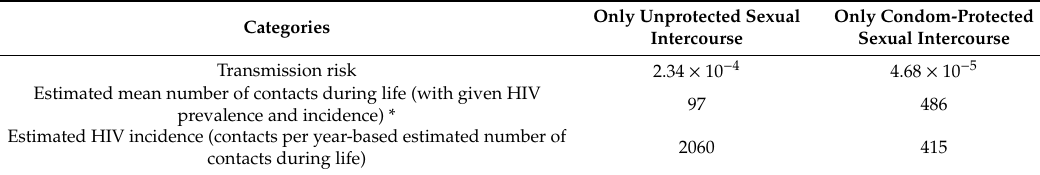
Table 2. Estimated mean numbers of sexual contacts and HIV incidence depending on use of condoms for prevention of transmission using Equations (4) and (6). Only individuals from the Haversath study [2] with exclusively heterosexual sex partners according to self-disclosure were